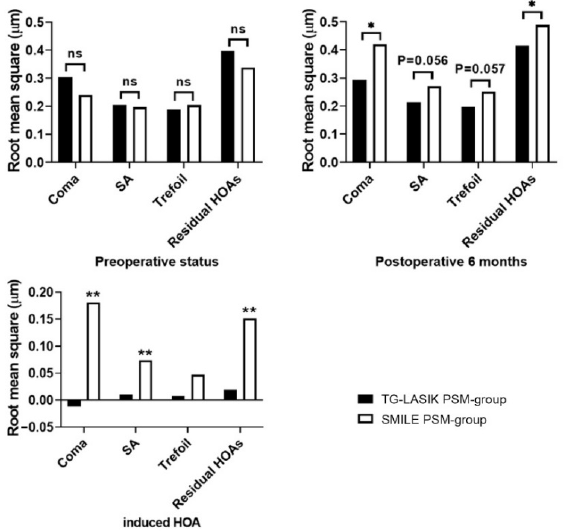
Figure 4. Changes in postoperative Snellen lines of CDVA compared with preoperative CDVA in TG-LASIK and SMILE propensity-score-matched groups. (TG-LASIK, topography-guided laser-assisted in situ keratomileusis; SMILE, small-incision lenticule extraction; UDVA, uncorrected distance visual acuity; CDVA, corrected distance visual acuity).